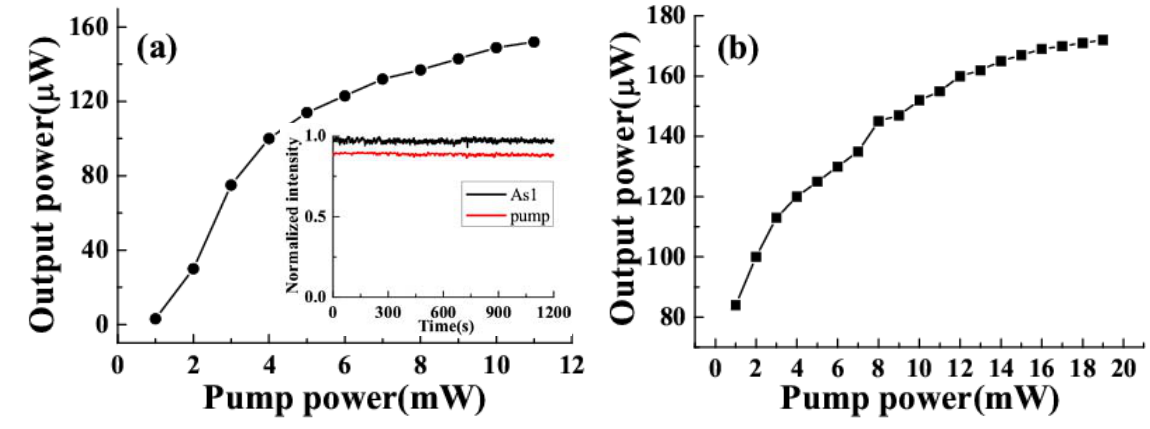
Figure 18. The dependence of the output power of AS1 on the power of one of the two input beams (a) dependence of beam1 power with the fixed power of beam2 of 19 mW;